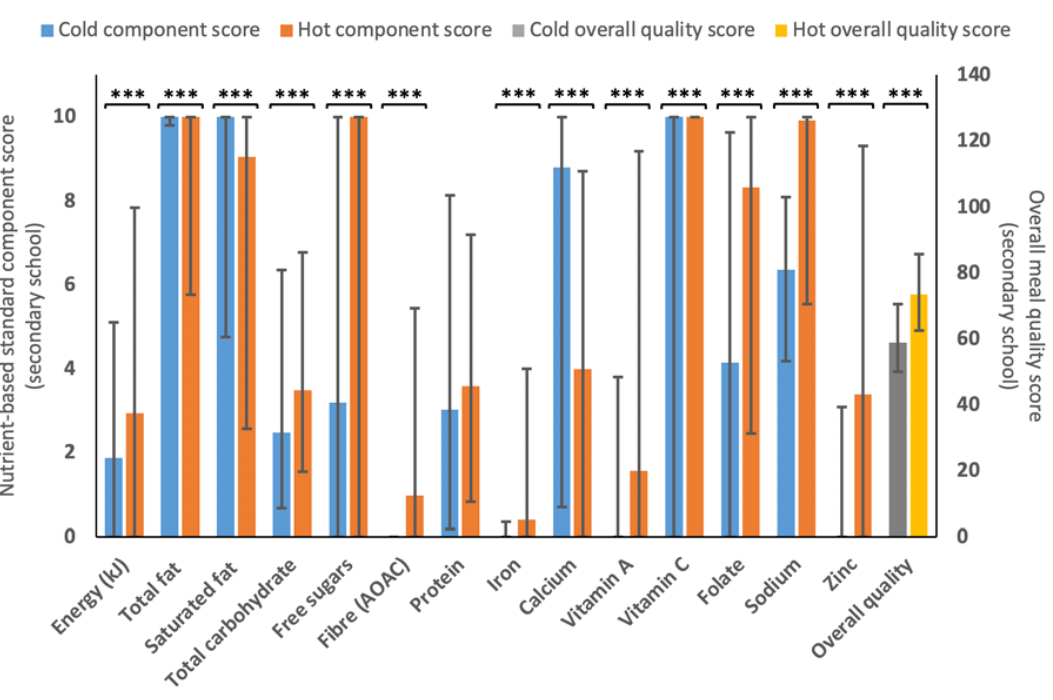
Figure 2. Median (IQR) for the different 11 – 18 years component scores and overall quality score for cold ( n = 1320) and hot ( n = 1439) menu variants. A statistically significant difference is represented by *** p < 0.001), as determined by Mann – Whitney U test.